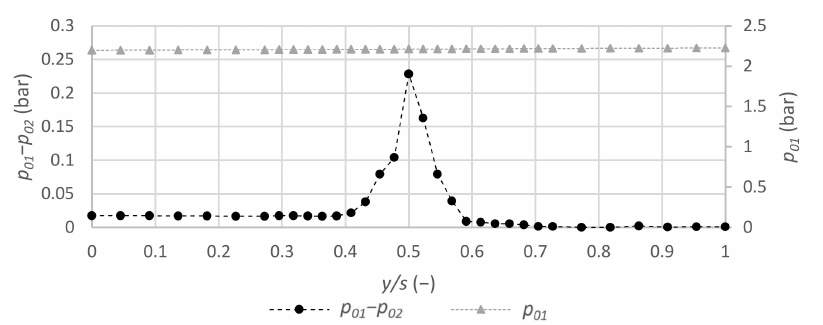
Figure 4. Examples of total upstream and total downstream pressure difference distributions (Novec 649, M 2is =